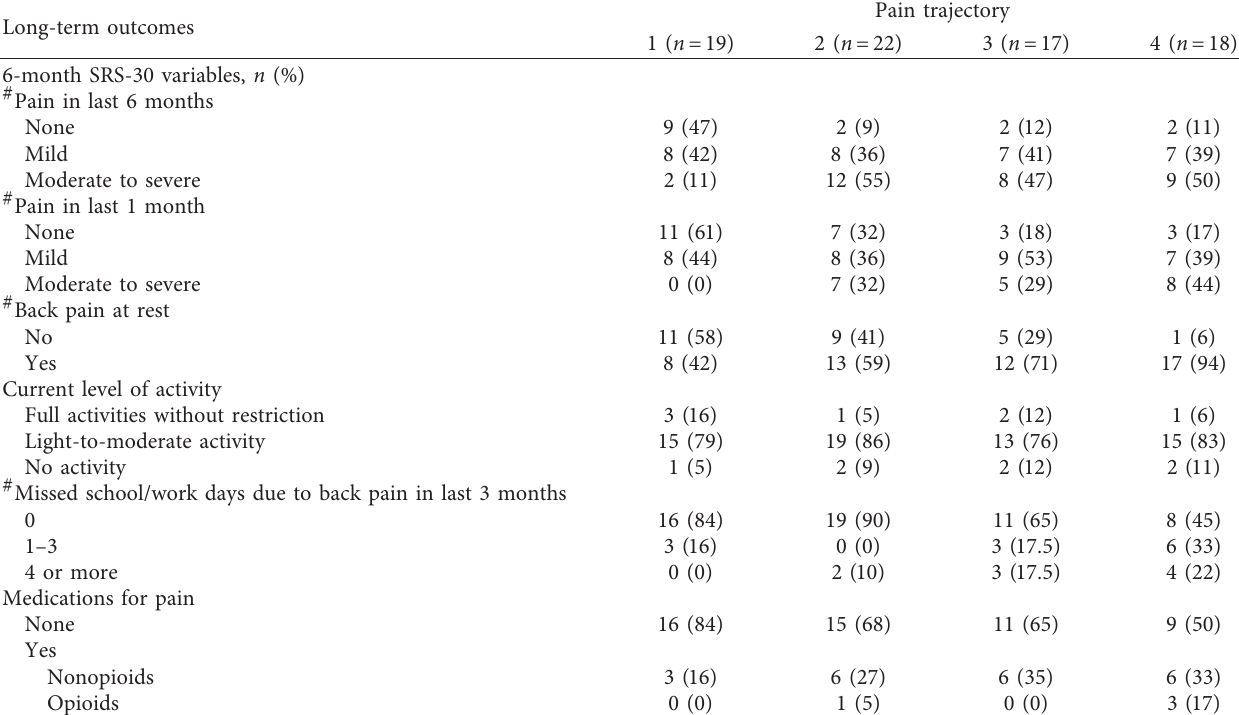
Table 4: Long-term outcomes according to pain trajectory membership.